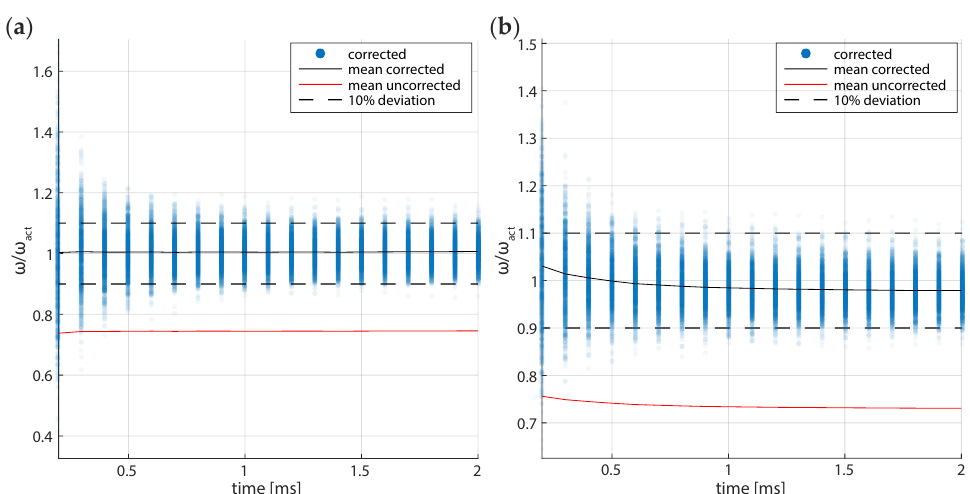
Figure 3. Relative angular trap frequency that is determined by force reconstruction via maximum- likelihood-estimator analysis (FORMA) with sampling time from the initial point. ( a ) Original and modified FORMA computed for an over-damped linear spring model. ( b ) FORMA computed for an accurate optical tweezers toolbox model for the same particle. The discretisation correction to FORMA improves the accuracy of calibration by about 25% for the case that we simulated. Dashed lines of 10% deviation from the simulation parameter value are overlaid as an eye guide.